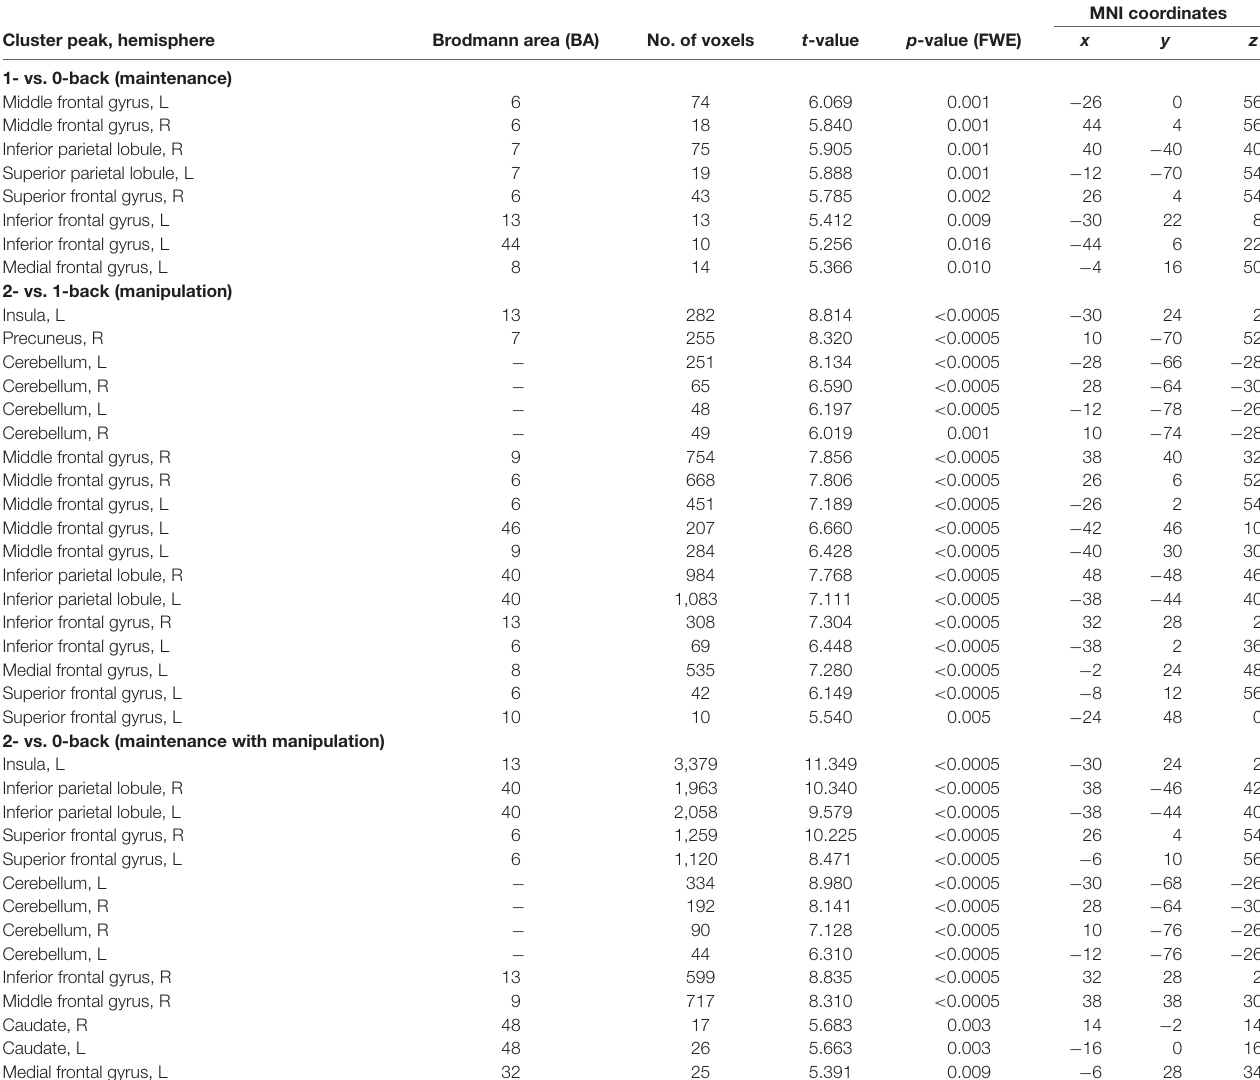
MNI coordinates